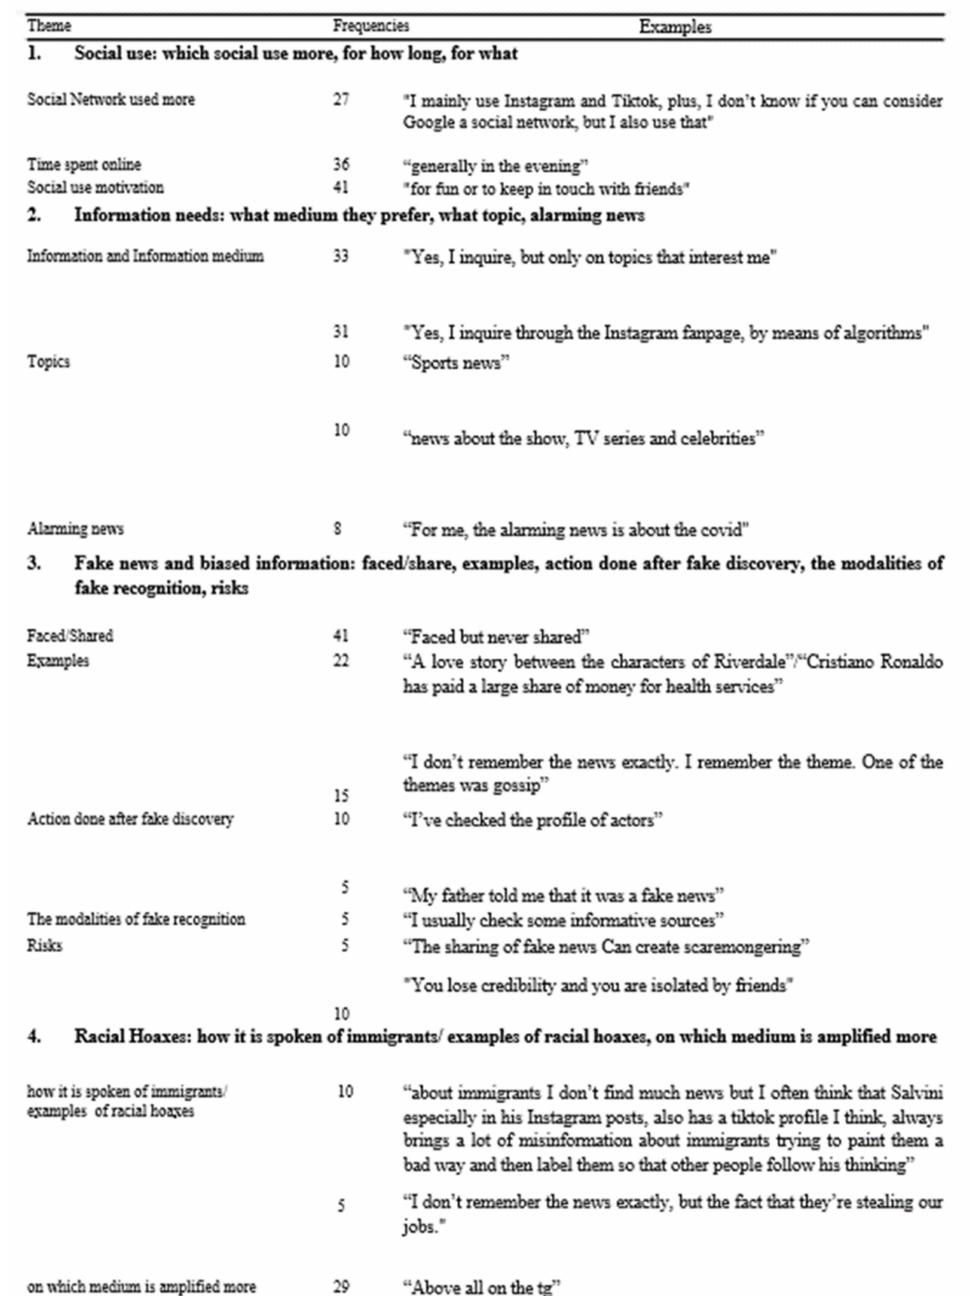
Figure 1. Focus group